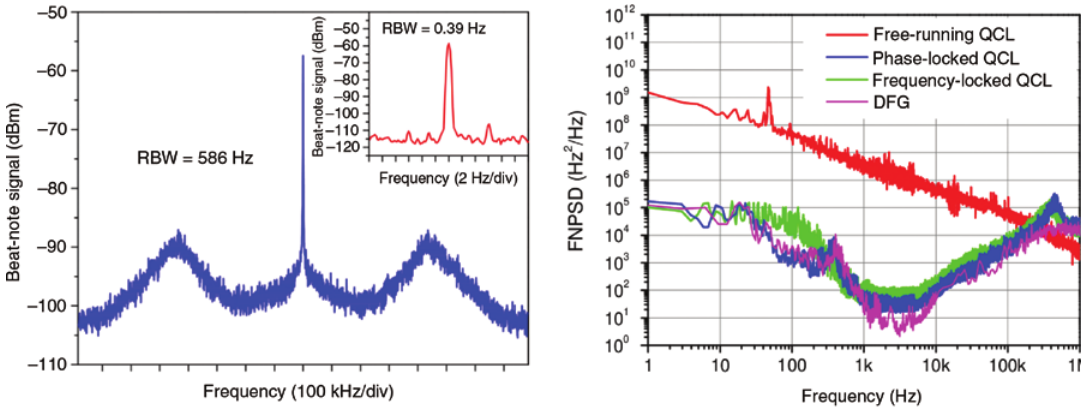
Figure 8: QCL beat note with the DFG source and FNPSDs (free-running and locked). Left: Beat-note signal between the DFG radiation and the phase-locked QCL. The inset shows the same beat note with a narrower span and resolution bandwidth. In both cases, the width of the peak (FWHM) is limited by the resolution bandwidth of the spectrum analyzer. Right: QCL FNPSDs in free-running and phase-locked conditions, acquired by using a CO amplitude converters, respectively. Reprinted with permission from [47], copyright